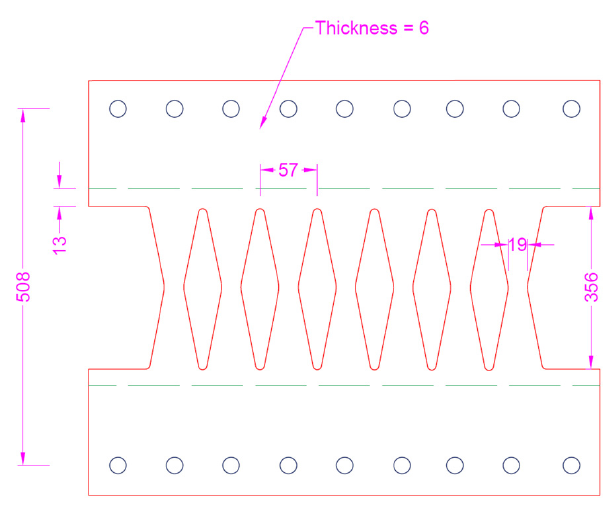
Figure 5. B09 − 56 specimen geometrical dimensions (in mm) [41].